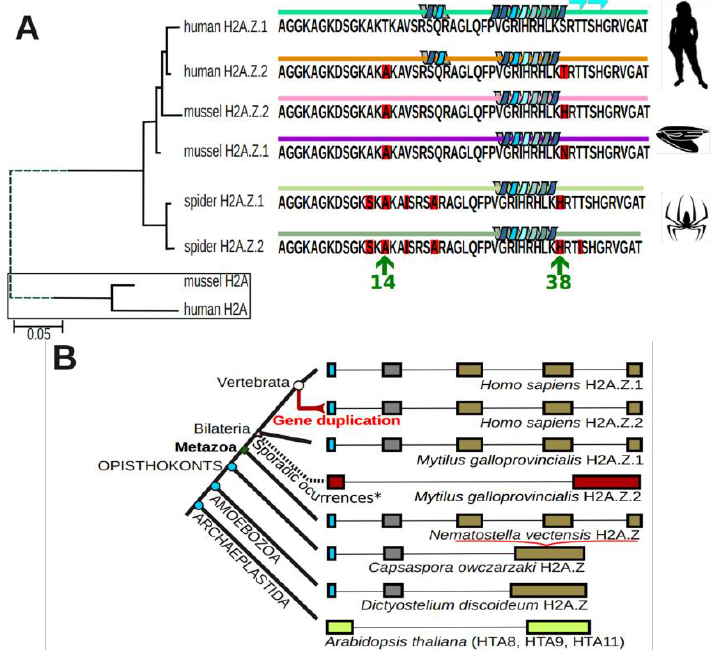
Figure 2. ( A ) Phylogenetic relationship among histone H2A.Z isoforms in Metazoa. A.Z-1 and H2A.Z-2 isoforms have a closer intraspecific than interspecific evolutionary relationship. ( B ) Major evolutionary transitions in histone H2A.Z organization in eukaryotes. Exon homology was inferred from the sequence length among di ff erent groups and represented by identical color. An increasing exon complexity appeared in the transition from protists to metazoans where possibly exons 3, 4, and 5 arose from exon 3 in protists ( Capsapora owczarzaki and Dictyostelium discoideum ). Introns are represented with arbitrary scales for comparative purposes. (Figure adapted from Figs 4 and 5 in [ 42 ]).